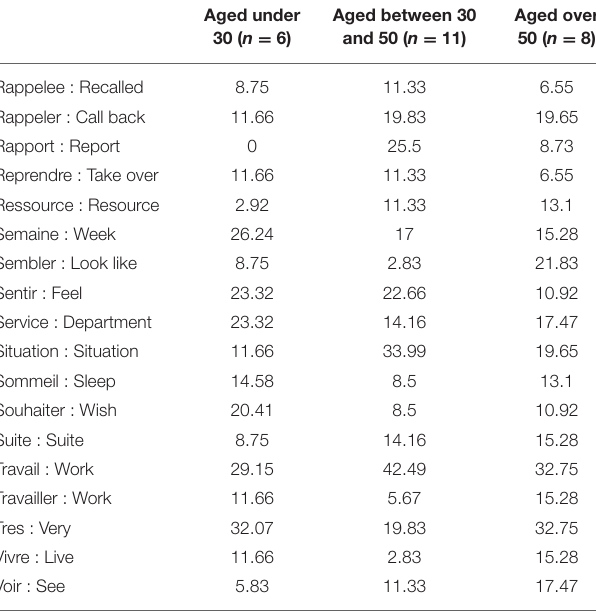
TABLE 2 | Forms of each class of age with the highest relative frequency in this class, and translation in English, in the alphabetic order.